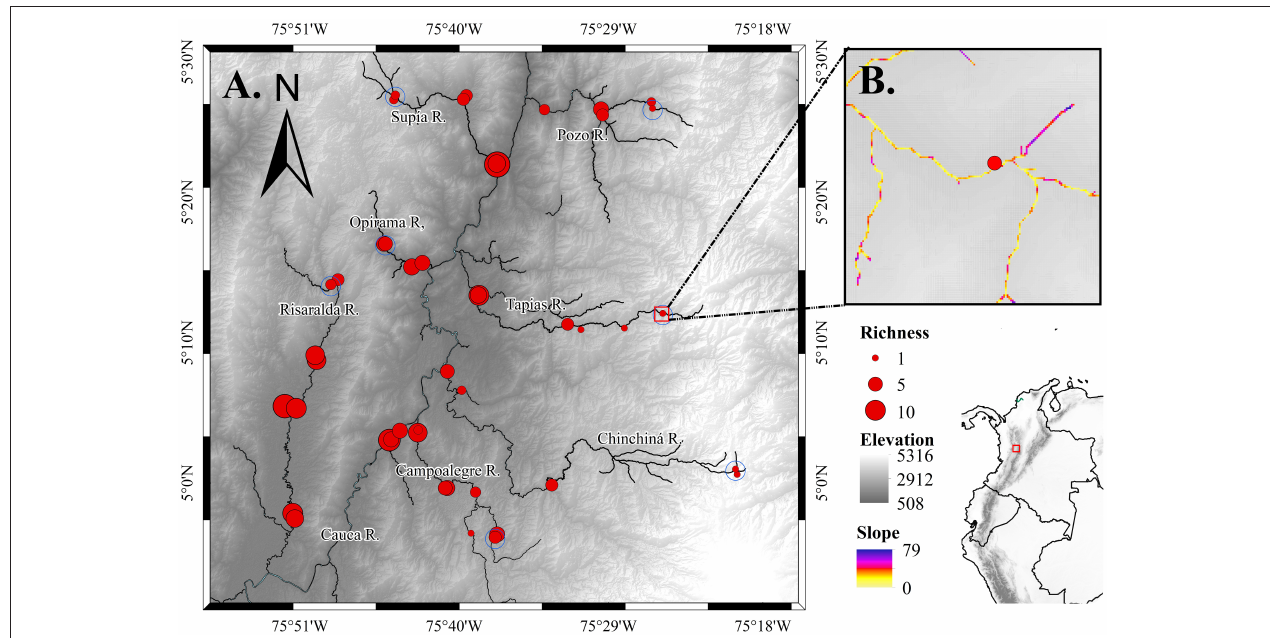
FIGURE 1 | (A) Hydrographic network of the study area. Circle size indicates species richness at each sampling site. Blue circles indicate sites that were used as headwater streams in the GDM. (B) Cost surface.